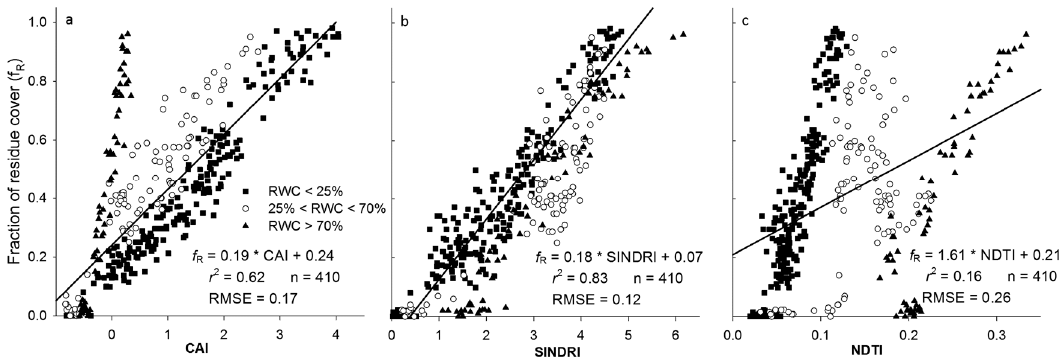
Figure 9. Fractions of maize residue cover on Matawan soil as a function of ( a ) CAI, ( b ) SINDRI and ( c ) NDTI for the range of scene RWC observed in the field experiments.